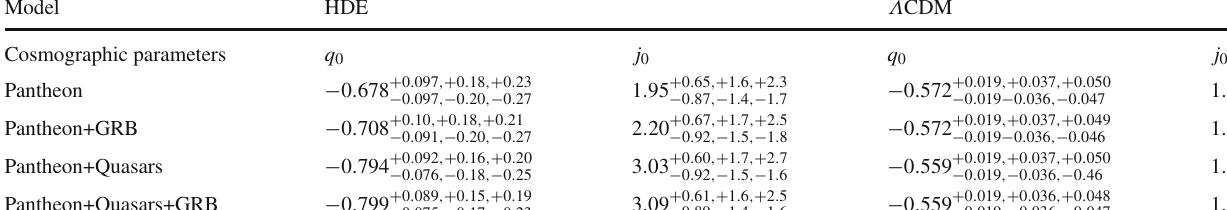
Table 2 Left part: the best-fit values of the cosmographic parameters q 0 and j 0 in the HDE model calculated within the 1 − σ , 2 − σ and 3 − σ errors obtained from the Hubble diagram of Pantheon, quasars and GRB. Right part: same as left part, but for the concordance Λ CDM model